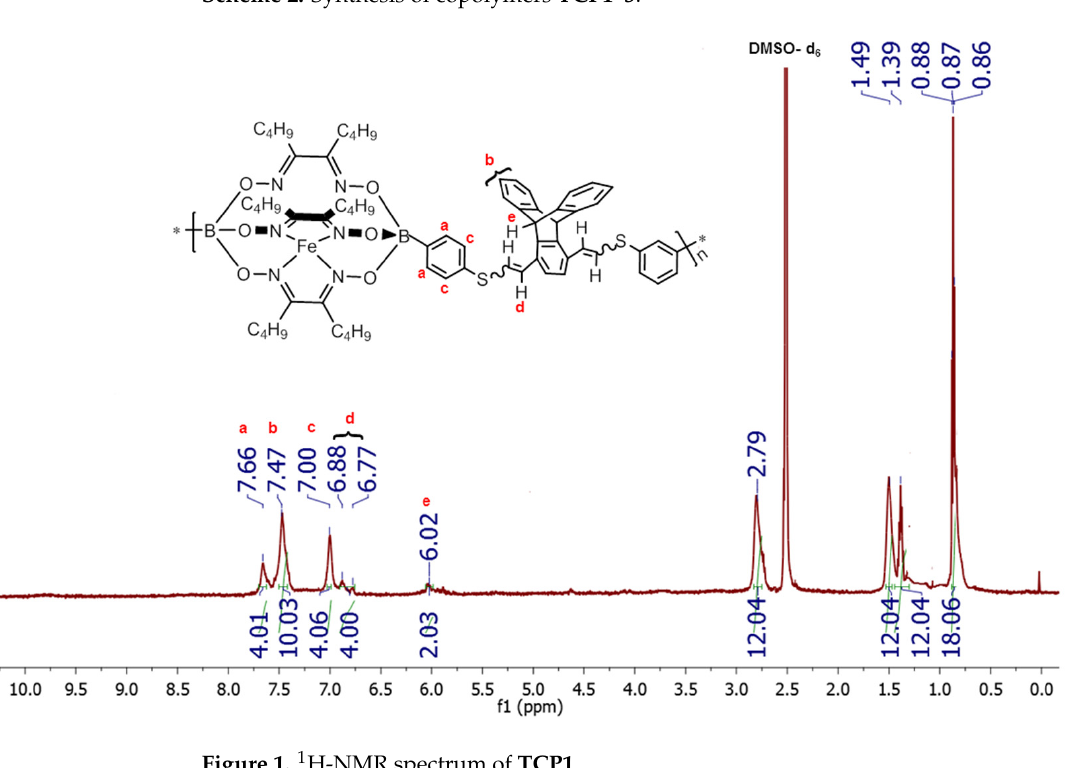
Figure 1. 1 H-NMR spectrum of TCP1.